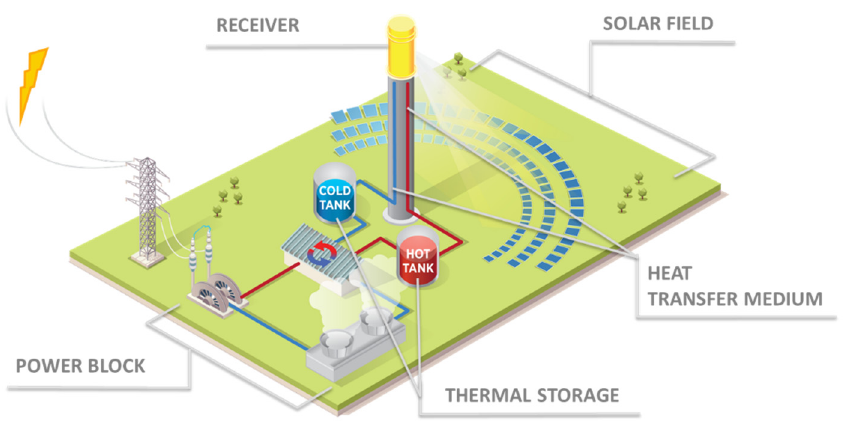
Figure 1. General layout of a CST system for electricity production. The receiver and HTM must enable the operating conditions of the application (here the power block) while physically and operationally integrating with the subsequent subsystem—TES.